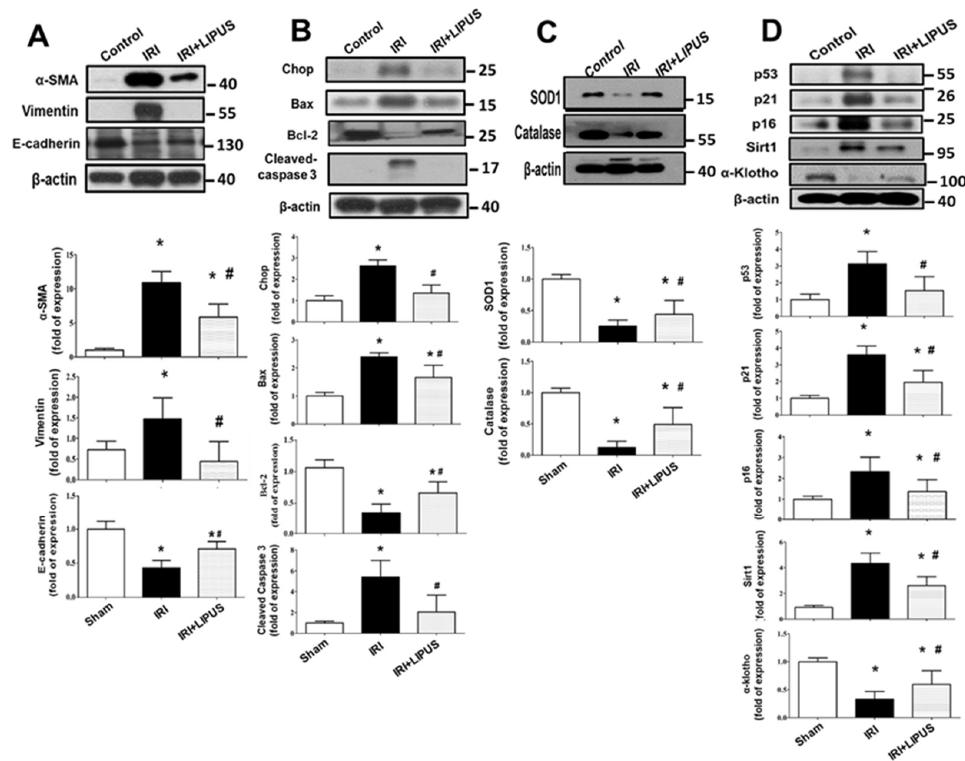
Figure 3. The effects of LIPUS on fibrosis-related signaling molecules, endogenous antioxidant enzymes, and senescence-related molecular signals in the kidneys of IRI-CKD mice (the mice were euthanized 14 days after IRI): the protein expression levels for fibrosis-related signaling molecules ( α -SMA, E-cadherin, and vimentin) ( A ); the protein expression levels for apoptosis-related signaling molecules (CHOP, Bax, Bcl-2, and cleaved caspase 3) ( B ); the protein expression levels for antioxidant enzymes SOD1 and catalase ( C ); the protein expression levels for senescence-related molecules (p53, p21, p16, Sirt1, and α -Klotho) ( D ). These levels in the kidneys were determined by Western blot. Quantifications for the protein expression are also shown. Data are presented as mean ± SD (n = 4–6): * p < 0.05 versus the control group; # p < 0.05 versus the CKD-alone